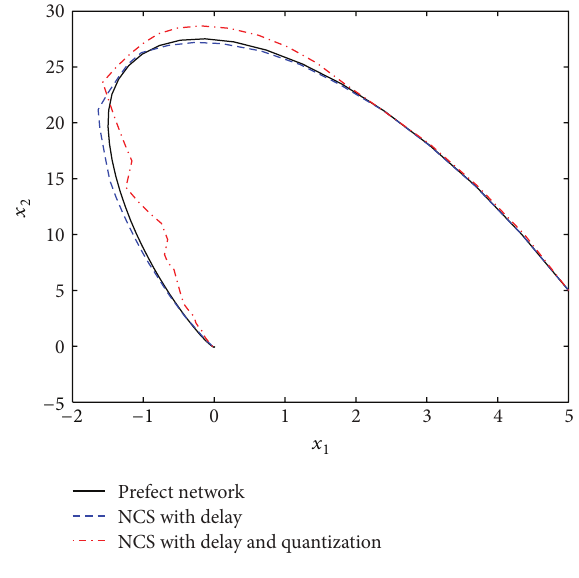
Figure 4: The state responses 𝑥 1 (Example 1).